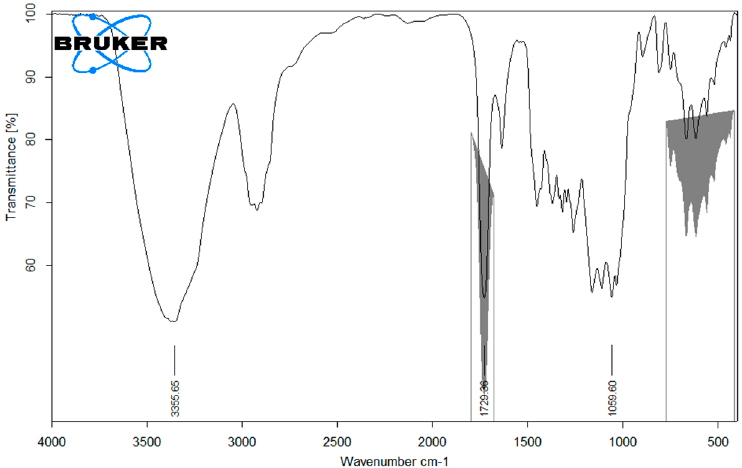
Figure 13. BNC-EGMA MS = 0.5 FT–IR spectrum. EGDMA ester group signal and cellulose reference signals in evidence.